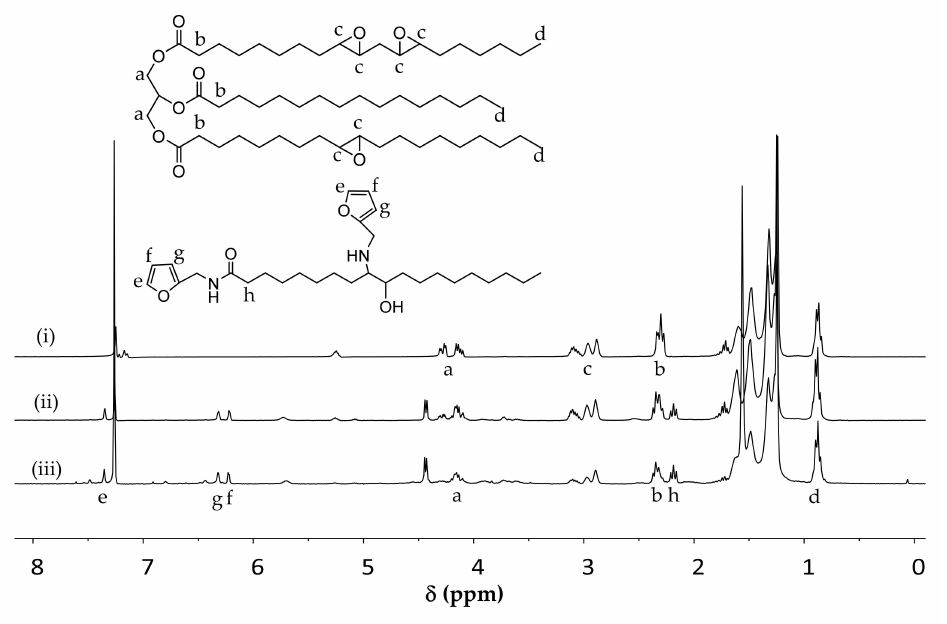
Figure 3. Proton NMR spectra of products of reactions without catalyst: ( i ) epoxidized oil, ( ii ) 80 ◦ C, 1:1, 5 h, ( iii ) 80 ◦ C, 1:5, 24